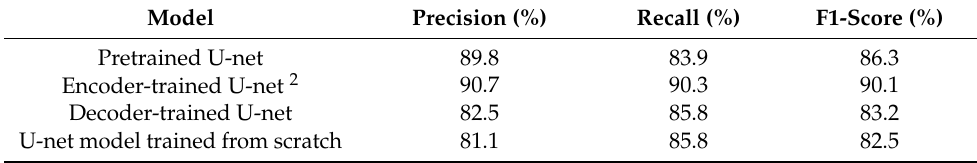
Table 5. Performance metrics of various U-net models on independent test dataset 1 .